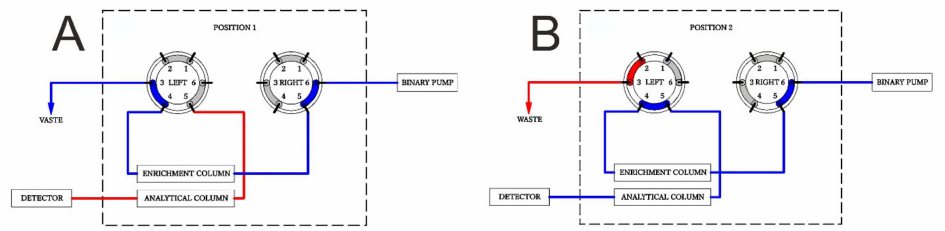
Figure 6. Scheme of SPE enrichment process in SPE-UHPLC-MS/MS method. Diagrams illustrating two positions of switching valve: ( A )—load position, ( B )—elute position. Enrichment column: Ac- quity UPLC BEH C18 Column (1.7 µ m, 2.1 × 50 mm) (Waters), loading solution: ammonium formate (10 mM; pH = 6.2)/ACN (30%), elution solution: ammonium formate (10 mmol/L; pH = 6.2)/ACN (30–90%)